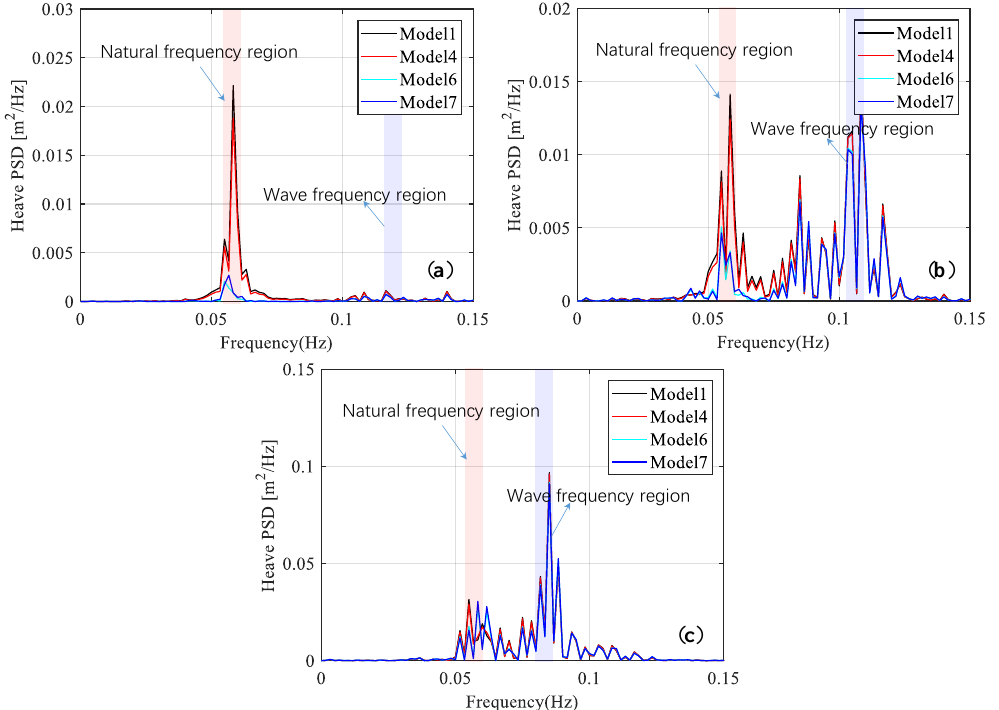
Figure 25. Comparison of the heave motion of Model 1, 4, 6, and 7 in the frequency domain: ( a ) LC4; ( b ) LC5; and ( c ) LC6.